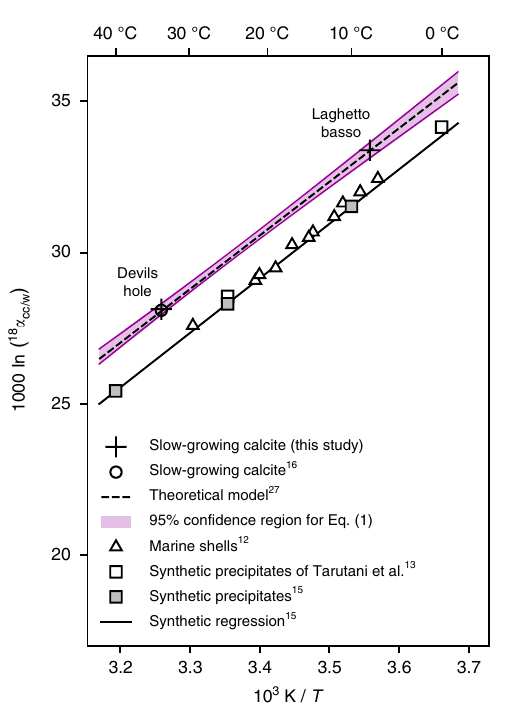
Fig. 1 Equilibrium 18 O/ 16 O fractionation between calcite and water ( 18 α cc/w ) as a function of crystallization temperature ( T ). The equilibrium baseline de fi ned by slow-growing calcites from Devils Hole and Laghetto Basso (colored con fi dence region, Eq. (2)) is indistinguishable from the theoretical prediction of Watkins et al. 27 (dashed line), which is quasi-identical to the original prediction by Coplen